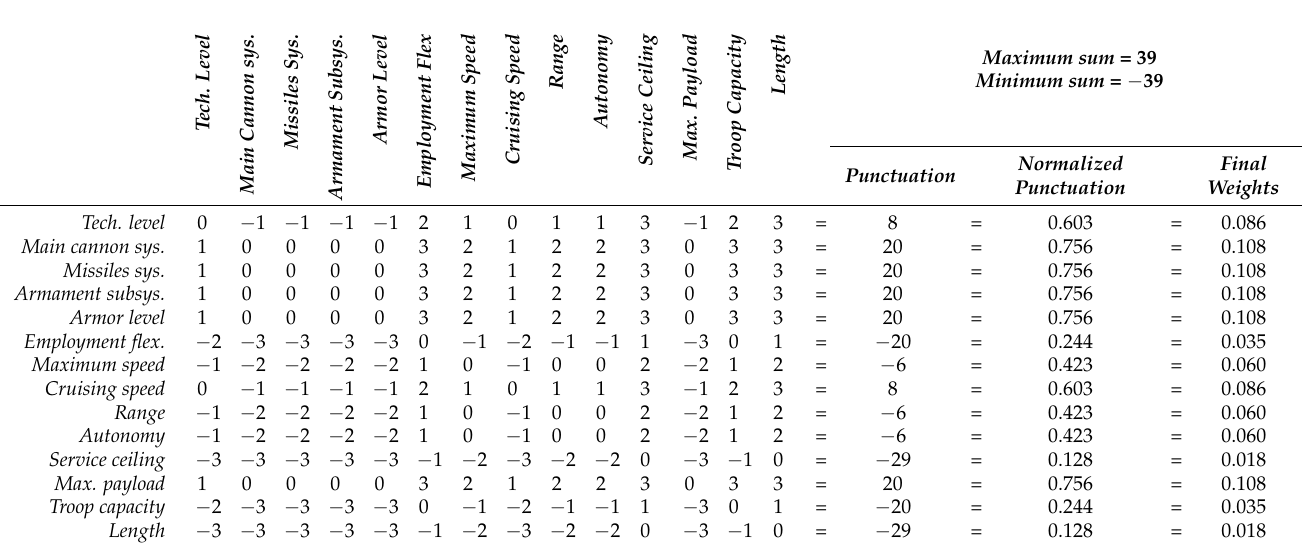
Table 12. Importance relation between criteria and weights obtained.